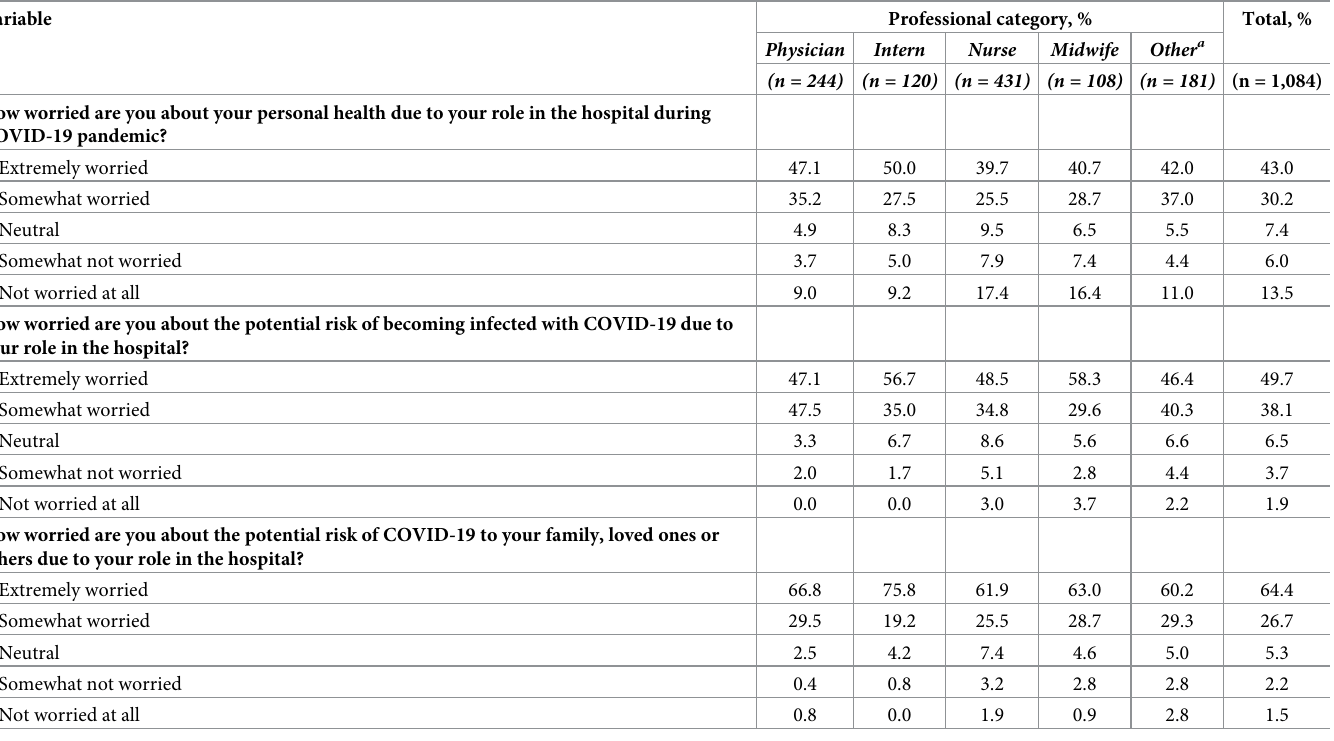
Table 3. Healthcare professional’s worry about their clinical role in the hospital during COVID-19 by professional category.